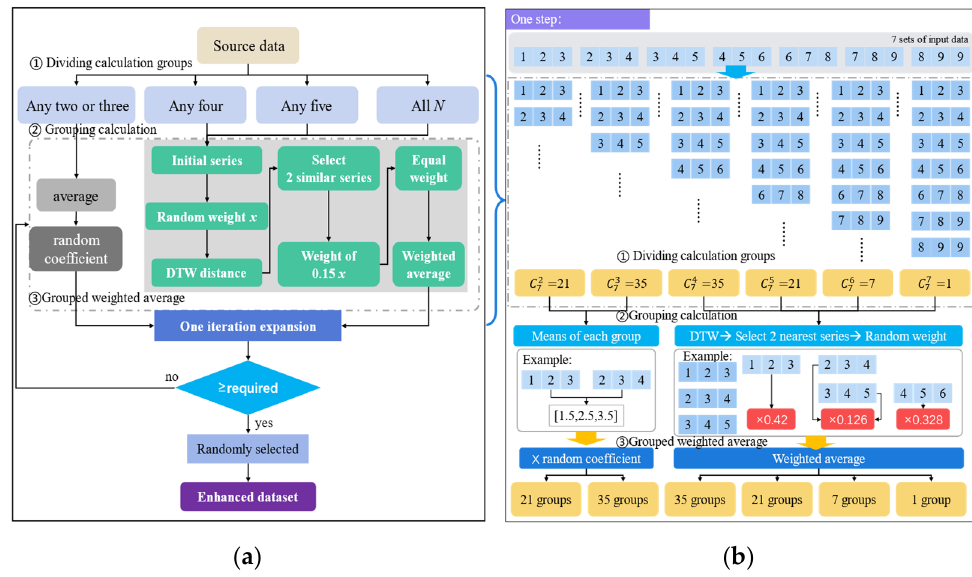
Figure 1. GRW-DBA algorithm flowchart: ( a ) algorithm flowchart; ( b ) schematic diagram of one-step data augmentation process.